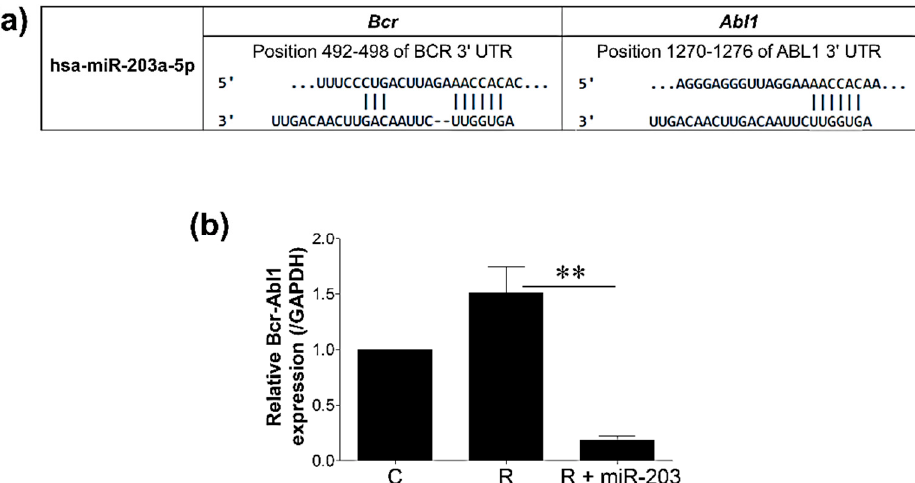
Figure 1. ( a ) Schematic illustration of predicted target regions of hsa-miR-203a-5p in 3 (cid:48) UTR of Bcr and Abl1 subunits of the Bcr-Abl1 oncogene using TargetScan ( b ) Relative gene expression of Bcr-Abl1 (/GAPDH) following miRNA transfection. C: imatinib-sensitive K562 cells R: imatinib-resistant K562 cells (IR-K562 cells), R + miR-203: IR-K562 transfected with hsa-miR-203a-5p. Data are presented as mean ± SD (n = 3) with statistical significance ** p ≤